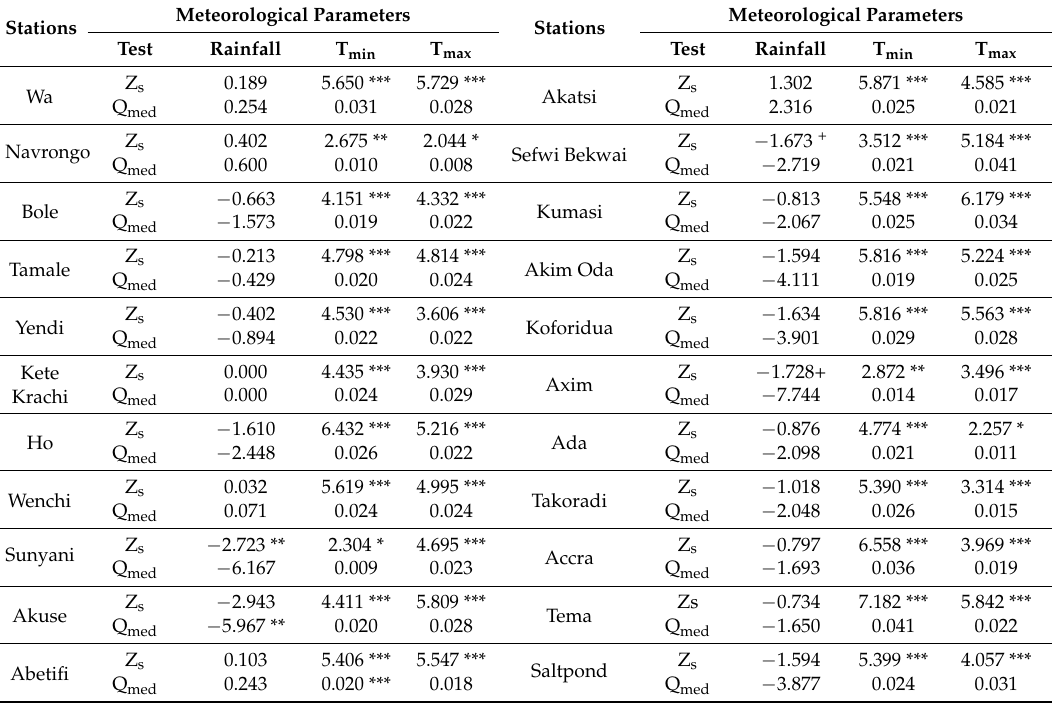
Table 2. Summary of the statistical trend